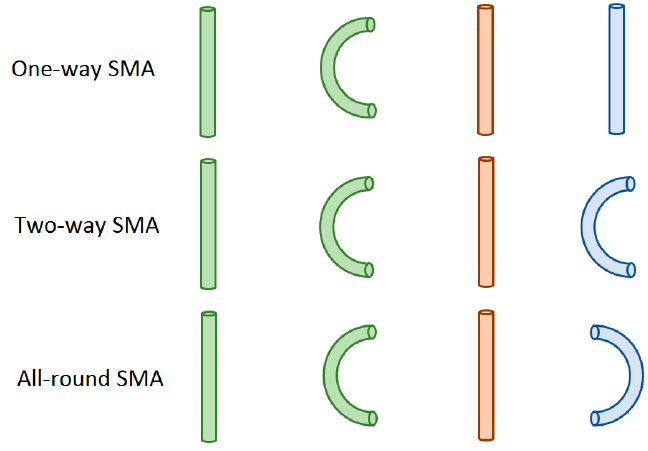
Figure 4. Different SMA shape memory effects.